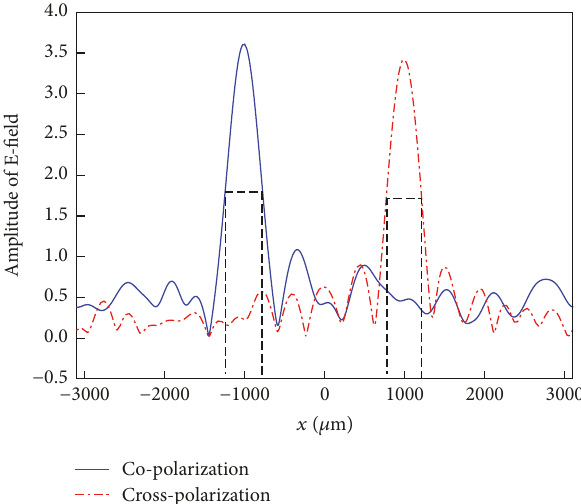
Figure 7: Electric field amplitude in the 𝑋 direction (extracted at 𝑍 corresponding to the focal points) for copolarization and cross- polarization waves,